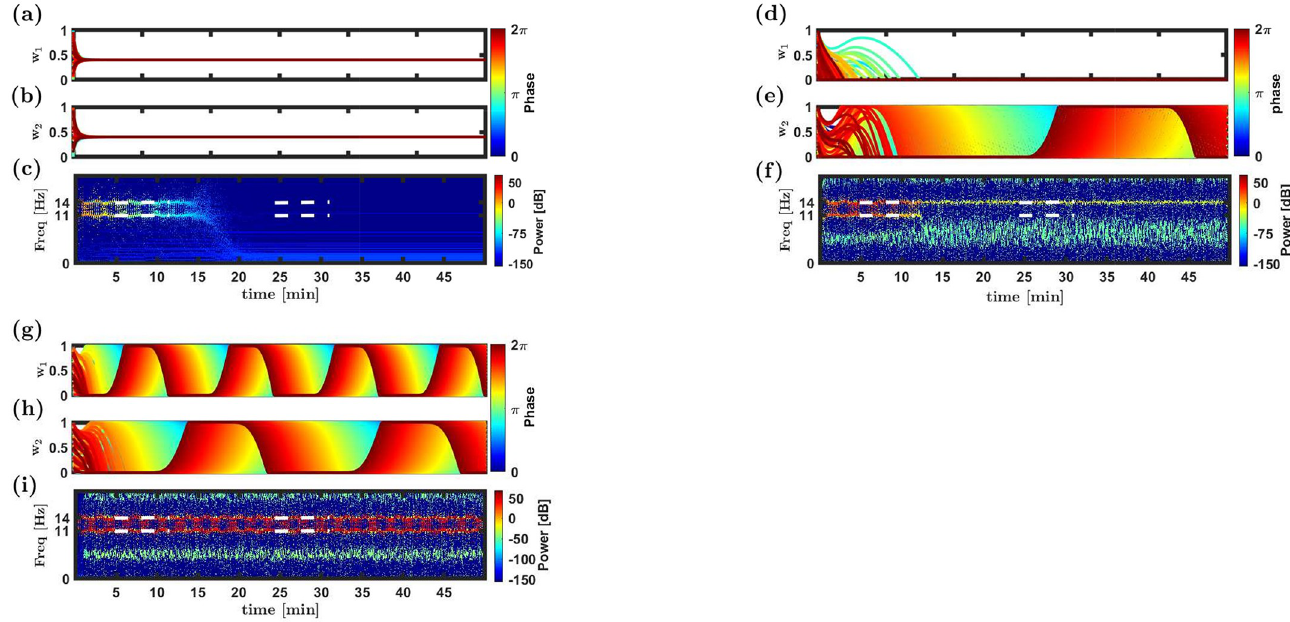
Fig 3. Three examples: Homogeneous solution, winner-take-all and multiplexing. Simulation results of the STDP dynamics in the limit of slow learning and a linear Poisson downstream neuron, Eq (13), are shown for three example cases. ( a )-( c ) The homogeneous solution, using μ = 0.1 and α = 1.05. ( d )-( f ) Winner- take-all competition, using μ = 0.001 and α = 1.1. ( g )-( i ) Multiplexing, using μ = 0.01 and α = 1.05. Panels a, b, d, e, g and h show the synaptic weights as a function of time. Each trace depicts the dynamics of a single synaptic weight. The synapses (traces) are differentiated by color according to the preferred phases of the corresponding pre-synaptic neurons, see legend. Panels c, f and i show the spectrogram of the downstream neuron. The horizontal dashed white lines depict the location of the rhythmic channels. In addition to the rhythmic channel (f) and rhythmic channels (i) one can identify sidebands in the spectrograms (f & i). Note that: 1) These additional bands are attenuated by about 100dB relative to the rhythmic channels. 2) They reflect the ongoing STDP dynamics; hence, they do not appear in c, and freezing the STDP abolishes these additional bands (results not shown). In all these examples the asymmetric learning rule, Eq (11), was used. The initial conditions of the synaptic weights were random. The synaptic weights at time zero were independent and identically distributed uniformly on [0, 1]. The parameters that were used in these examples are: ν 1 = 11Hz, ν 2 = 14Hz, N = 120, λ = 0.001, γ = 1, D = 10Hz, σ = 0.8, d = 10ms, τ + = 20ms and τ − = 50ms.